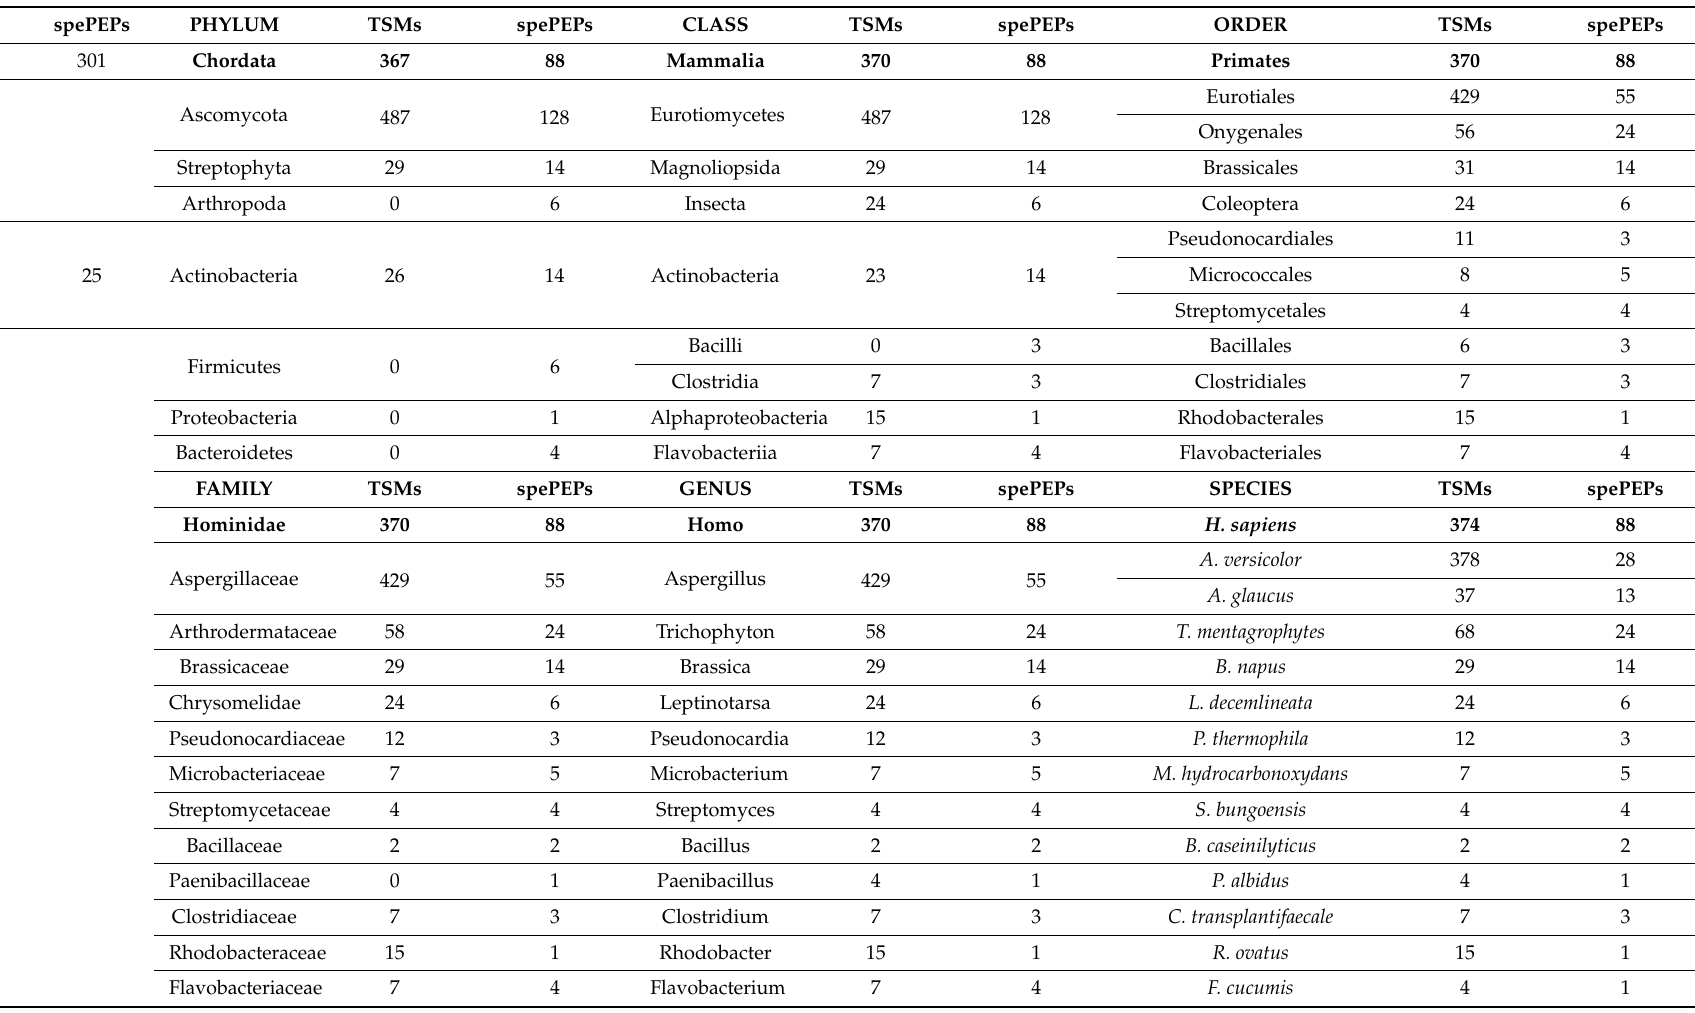
Table 1. Taxonomical assignment by tandem mass spectrometry